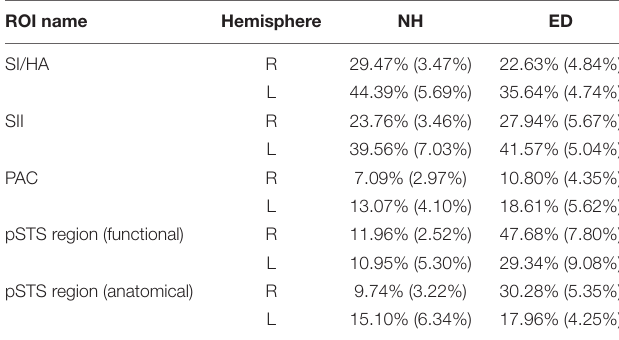
ED (right: 32.91% ± 2.81%, left: 15.36% ± 4.70%) and NH (right: 33.36% ± 4.16%, left: 14.89% ± 4.80%) as can be seen in Figure 3 .